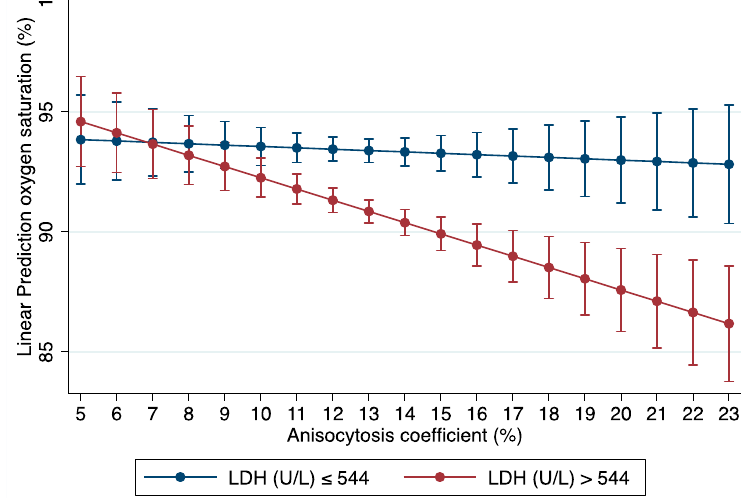
Figure 1. Graph of interaction between LDH level and anisocytosis coefficient as important variables for the prediction of oxygen saturation in COVID ‐ 19 patients.